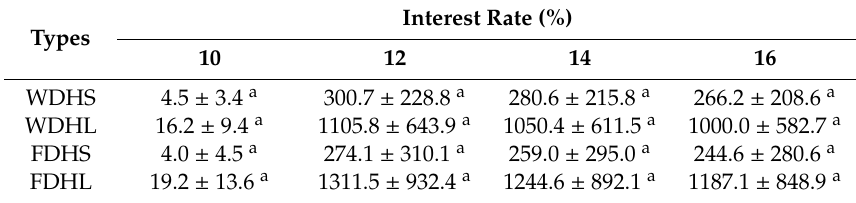
Table 8. Sensitivity of NPV on di ff erent home garden types and sizes to changes in di ff erent interest rates on 10%, 12%, 14%, and